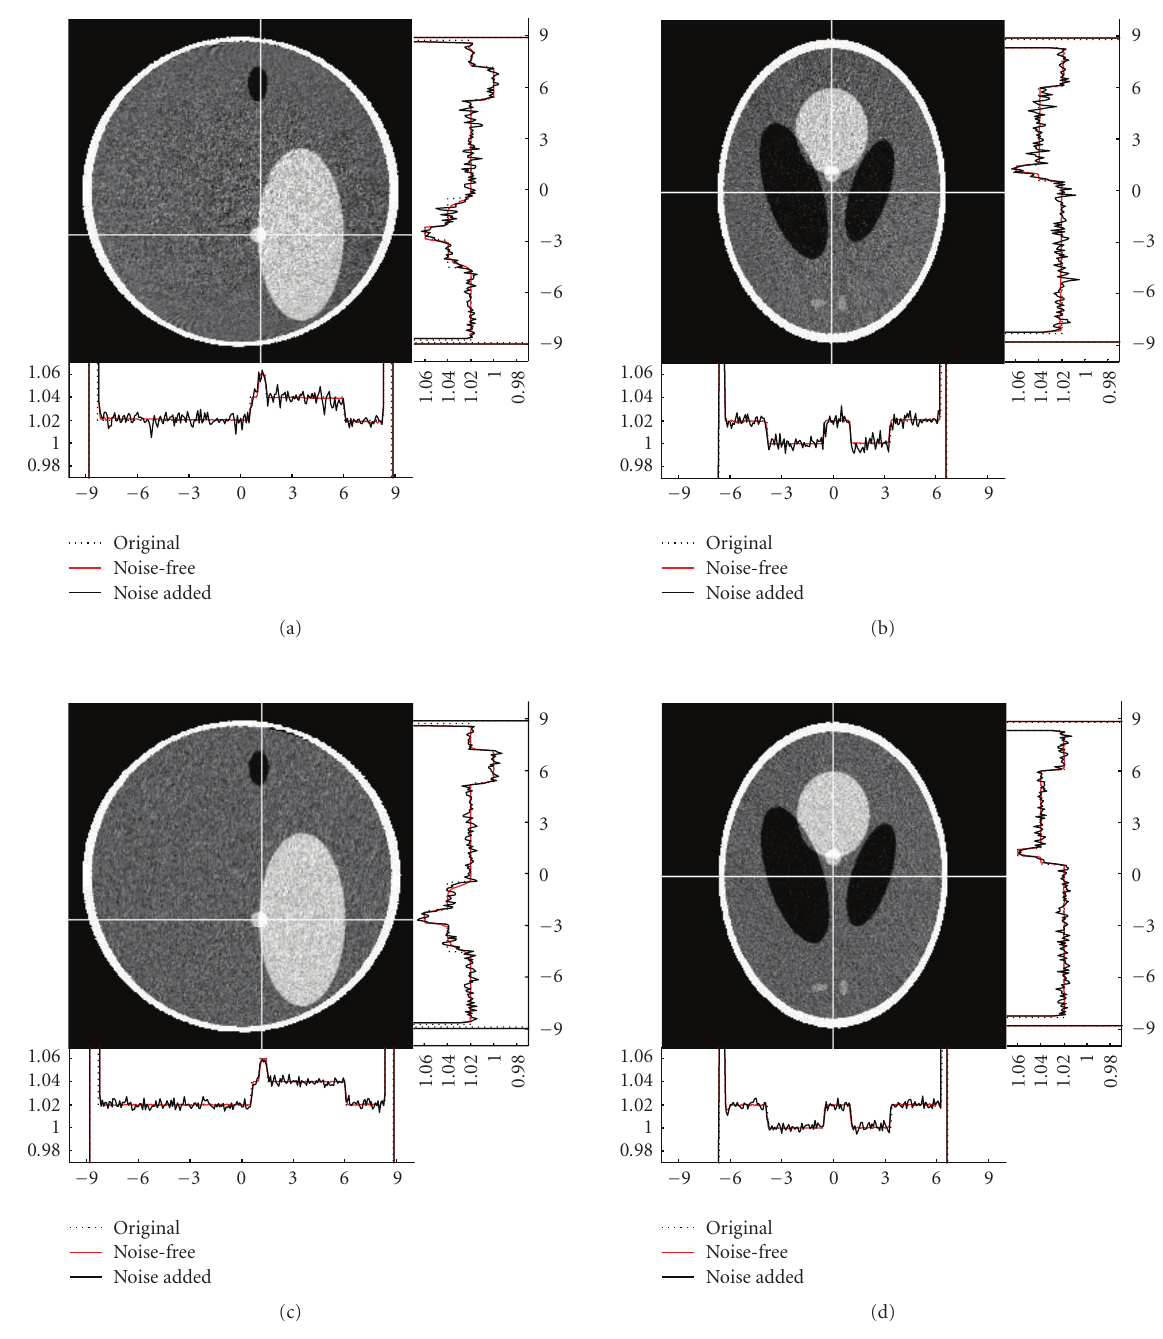
Figure 7: Same as Figure 6 but from noisy data with N 0 = 10 6